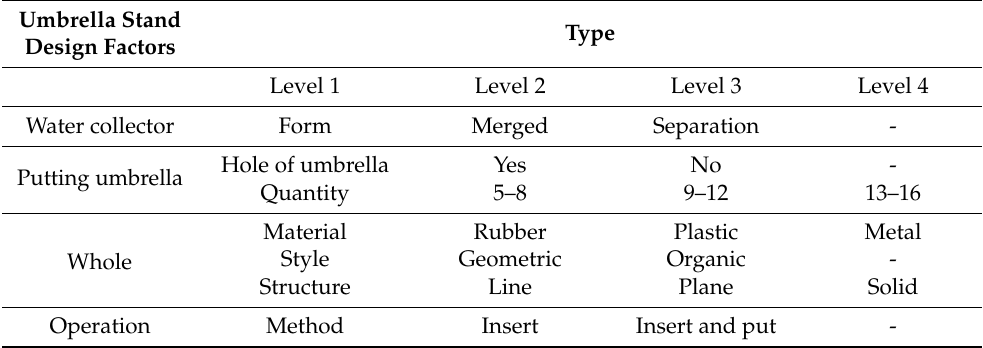
Table 1. Summary of umbrella-stand design